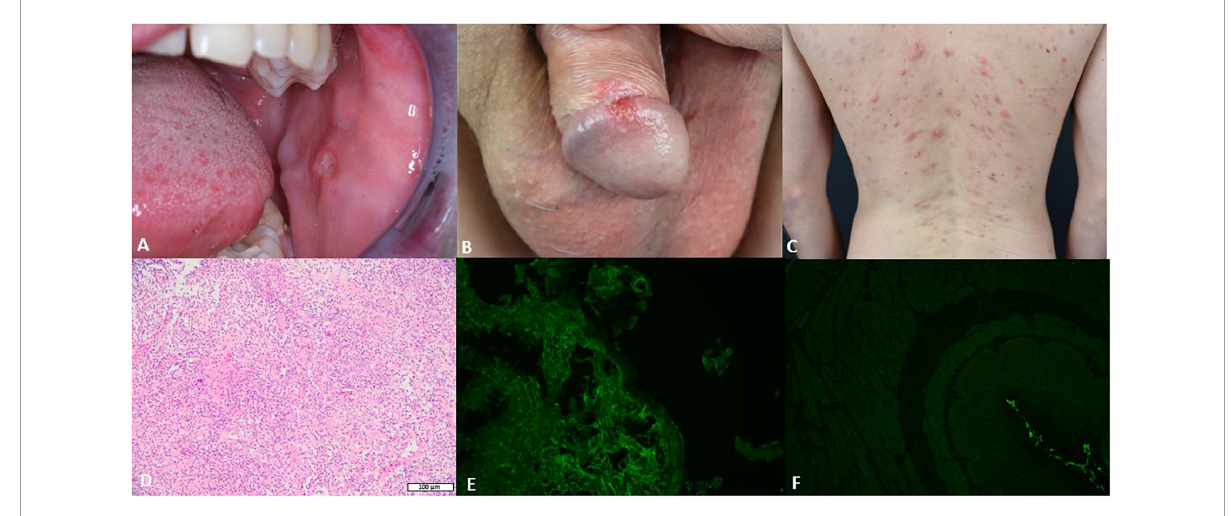
FIGURE1 The clinical, histological, and serological features of the patient. (A) Single buccal erosion with a sharp border. (B) Erosion on the penis with a sharp border. (C) Acneiform eruption with sterile pustules. (D) Biopsy from the oral ulceration with a massive infiltration of neutrophils, lymphocytes, and plasma cells (H&E 10 × ). (E) Negative direct immunofluorescence (DIF) on a biopsy from the oral mucosa. (F) Negative indirect immunofluorescence (IIF) on monkey